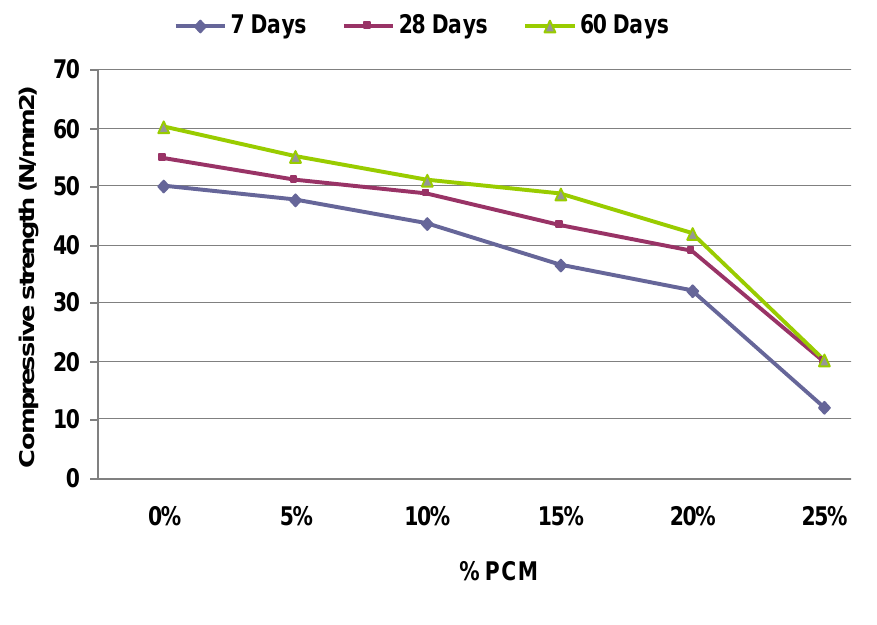
Figure 5. Mechanical compressive strength at 28